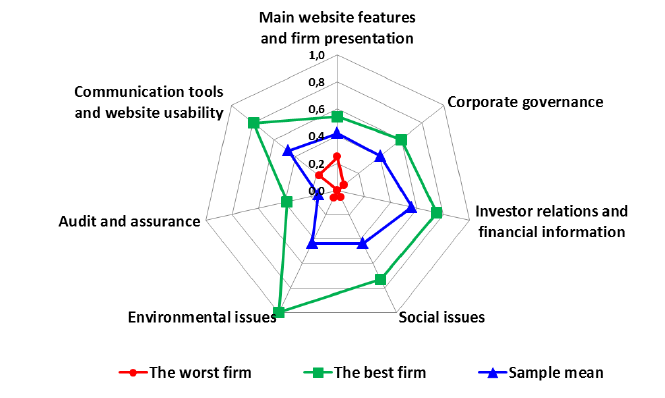
Figure 1: Comprehensive Disclosure Index: Examples from the Sample